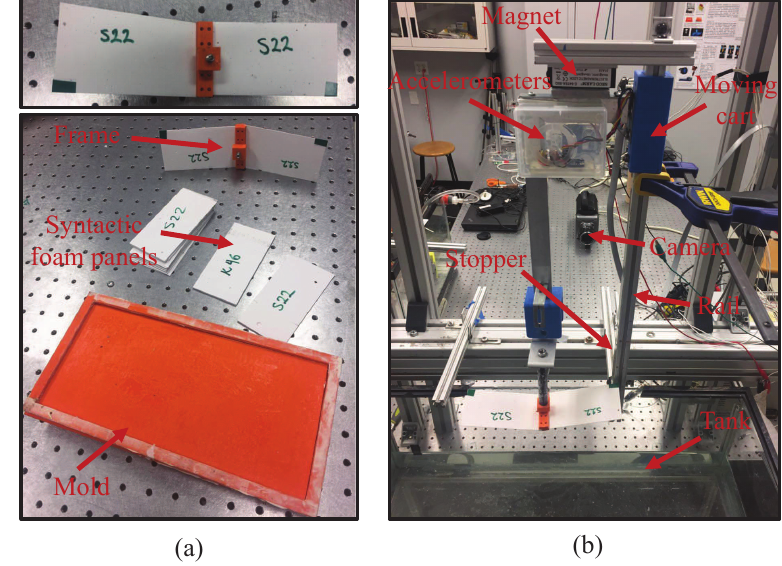
Figure 1. ( a ) In-house made mold for fabrication of thin syntactic foam panels, and custom-made frame to hold the panels during water impact; ( b ) Experimental setup with overlaid nomenclature of the